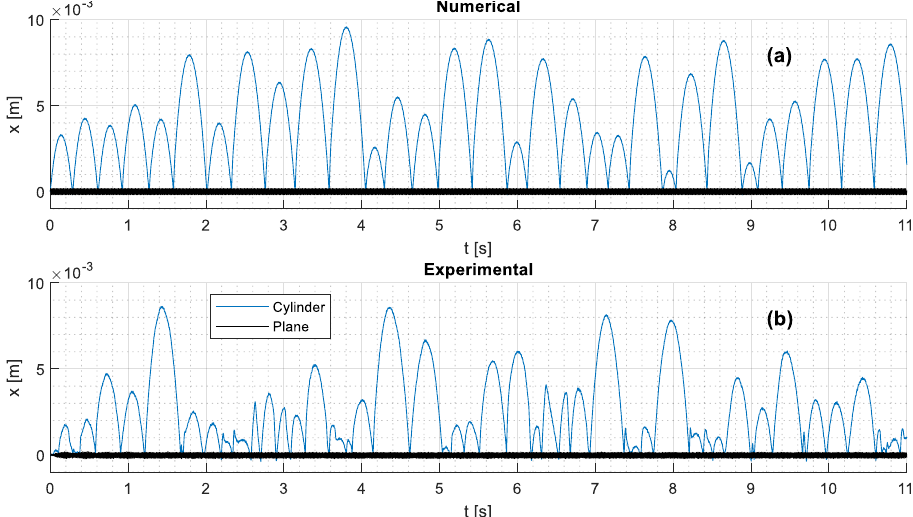
Figure 20. Comparison between numerical ( a ) and experimental ( b ) results. θ = 3 ◦ , ψ = 10 ◦ , f = 55 Hz, a / g = 2.254, k = 1,000,000 N / m, f v = 0.005, µ c = 0.35 and µ s = 0.7.